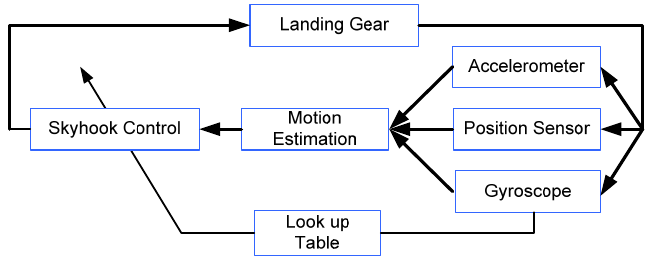
Figure 9. Skyhook controller block diagram.